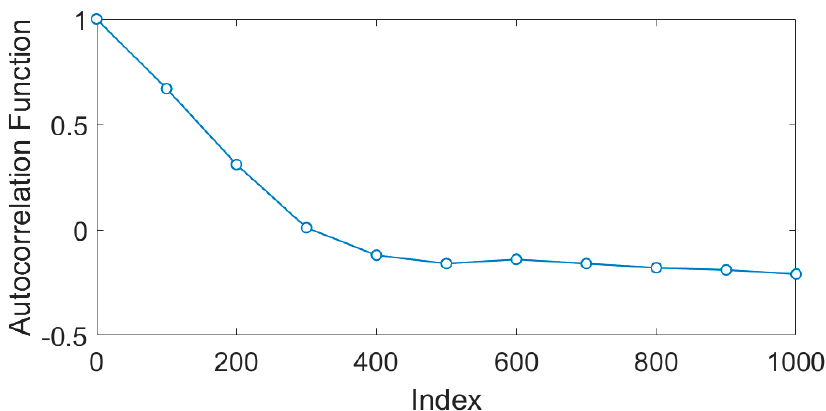
Figure 8. The autocorrelation function (ACF) of the mill load time series showing a low to negligible value at an index exceeding a window length of b = 250.